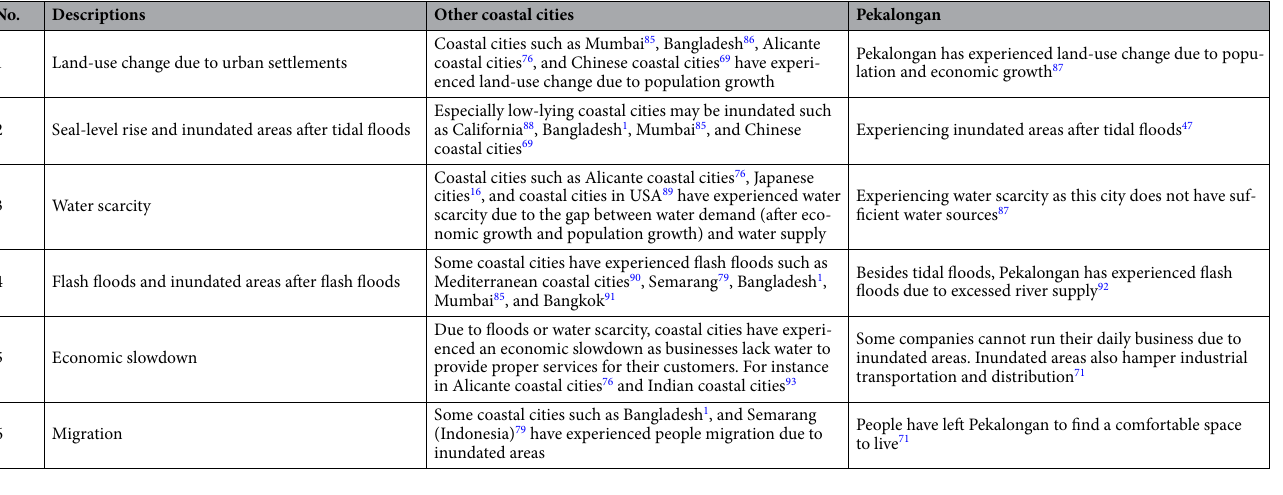
Table 1. Similarities between Pekalongan and other coastal